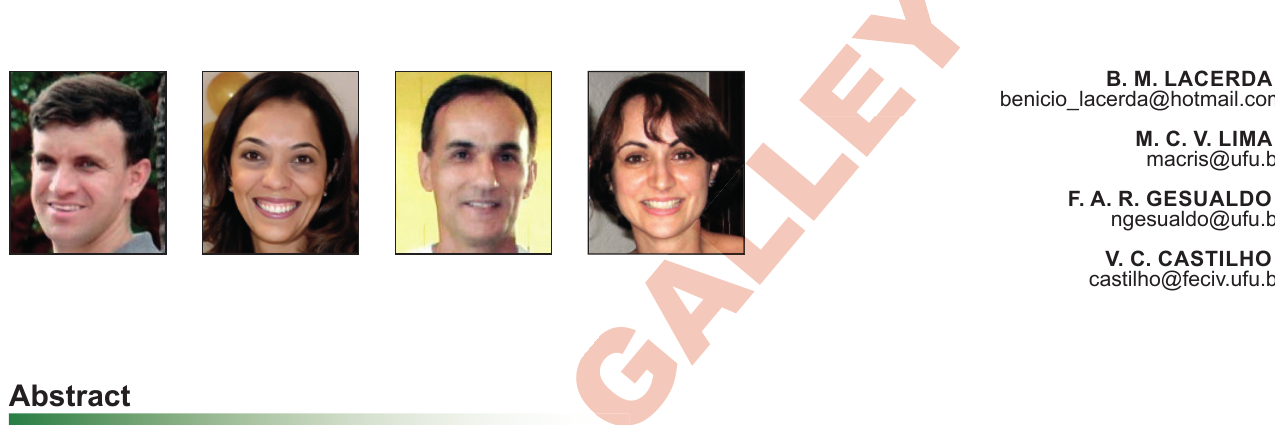
Este estudo apresenta uma investigação experimental e numérica dos fatores que interferem na resistência ao cisalhamento da interface entre concretos de estruturas formadas por painéis duplos treliçados, submetidos ao cisalhamento direto. O programa experimental foi realizado por meio do ensaio de 26 modelos submetidos ao cisalhamento direto, com a largura do concreto de preenchimento variando de 7 cm, 9 cm e 13 cm, com interfaces lisas e rugosas, além de diferentes resistências à compressão do concreto na região de preenchimento. A modelagem